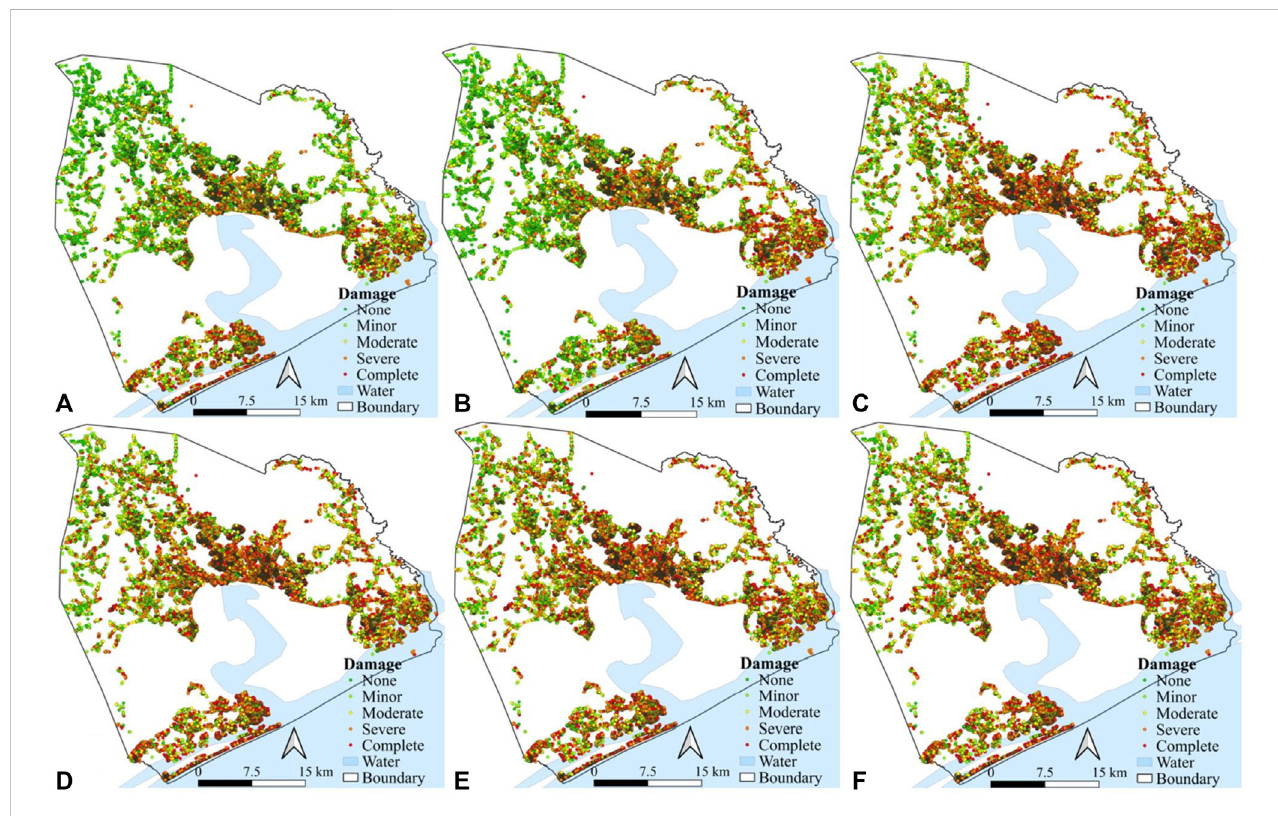
FIGURE 10 Building damage maps for hurricanes: (A) P1, (B) P2, (C) P3, (D) P4, (E) P5 and (F) Helene.